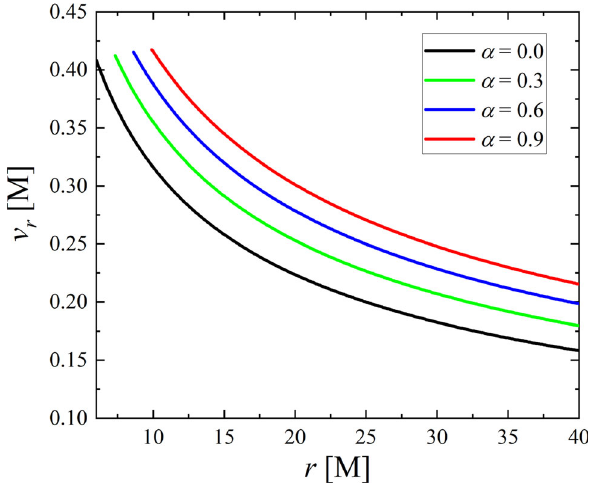
Fig. 7 Linear velocity v r plotted versus radius r of the accretion flow for various values of α